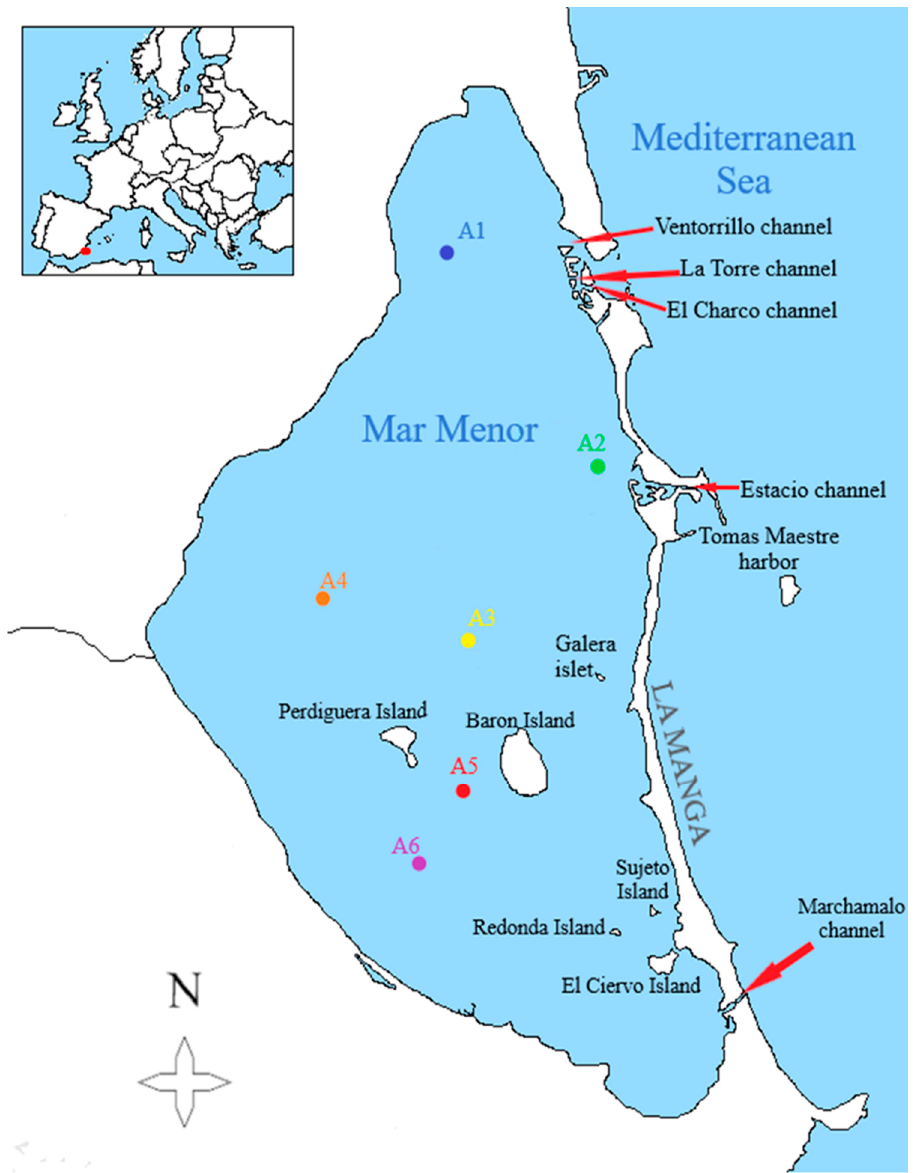
Figure 1. Map of the Mar Menor lagoon with the location of the sampling points, on a scale of 1/152,000 (own elaboration).